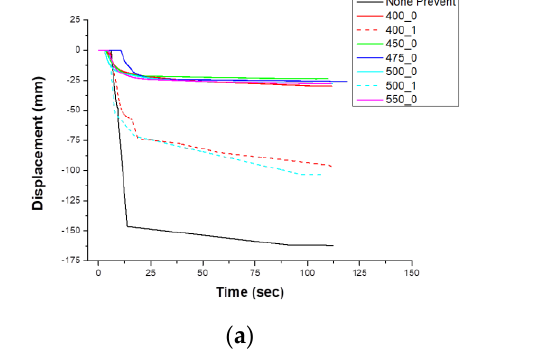
Figure 16. Settlement of grouting mixing ratio and separation distance. ( a ) Settlement of grouting mixing ratio. ( b ) Settlement of separation distance.